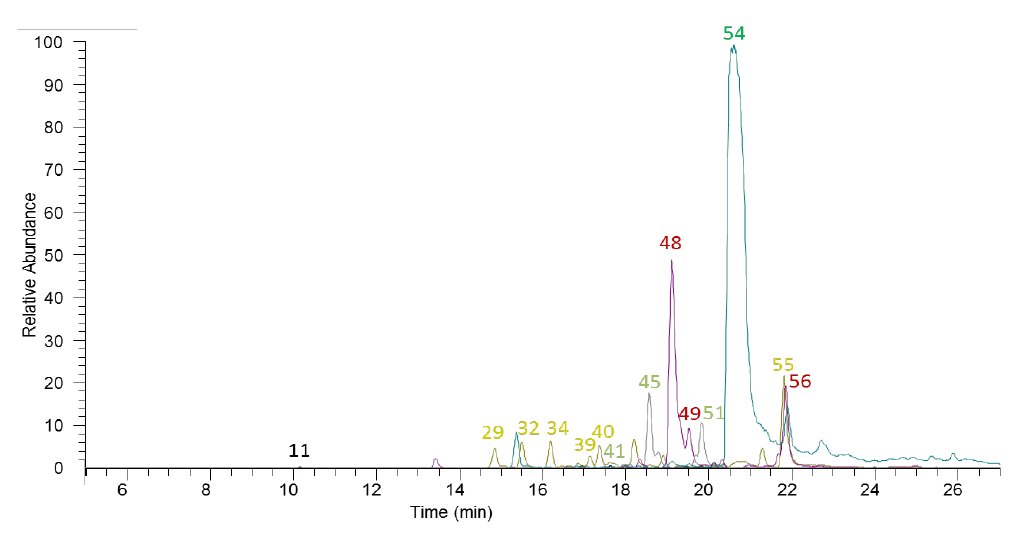
Figure 1. Main rosemary (poly)phenolic compounds. Peak numbers refer to components listed in Table 1.